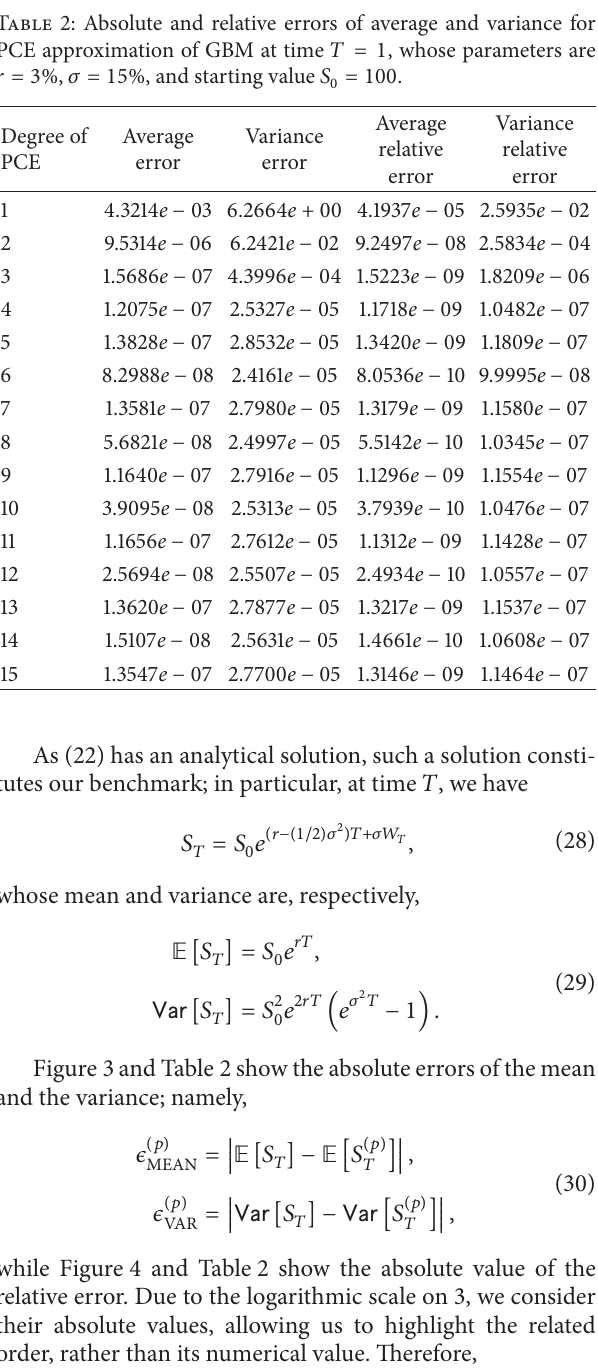
Table 2: Absolute and relative errors of average and variance for PCE approximation of GBM at time 𝑇 = 1 , whose parameters are 𝑟 = 3 %, 𝜎 = 15 %, and starting value 𝑆